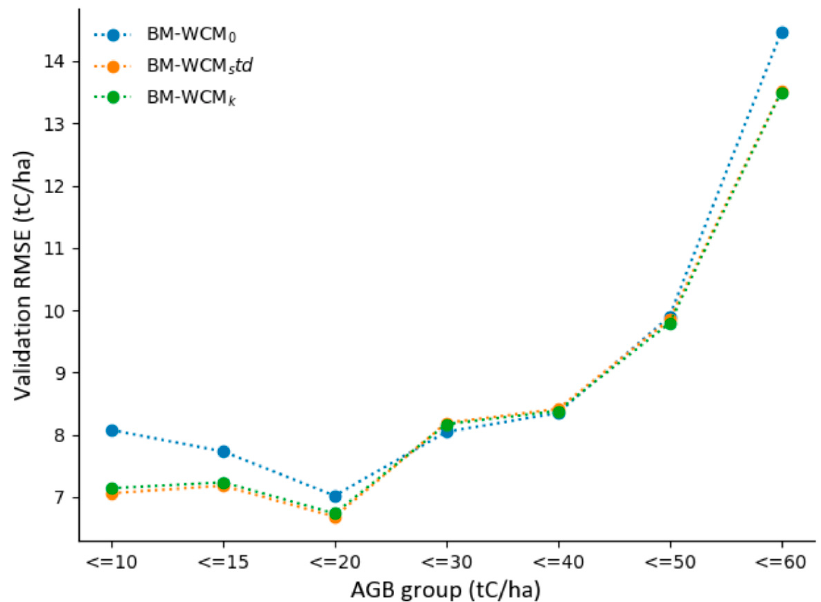
Figure 7. Validation RMSE val (Equation (15)) compared between different AGBC groups and